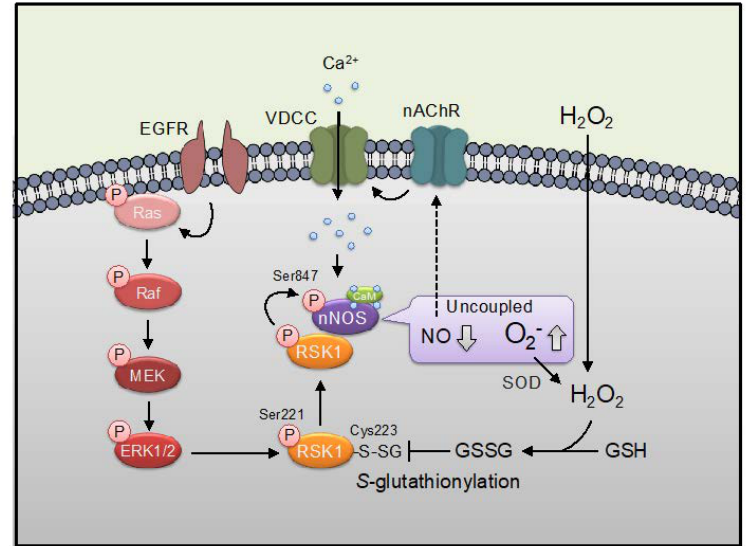
Figure3. HarmonizationofCa 2 + , EGF,andoxidativesignals. Ca 2 + influxinducedbyvoltage-dependent calcium channel (VDCC) via nicotinic acetylcholine receptor (nAChR) activates nNOS, leading NO production. MAPK signaling (Ras / Raf / MEK / ERK) induced by EGF stimuli evokes activation of RSK1 signaling which induces phosphorylation at Ser847 of nNOS. Phosphorylation at Ser847 switches nNOS reaction from NO synthesis to superoxide (O 2 − ) synthesis via induction of uncoupling of nNOS [76] Superoxide is converted to H 2 O 2 by superoxide dismutase (SOD). Oxidative stimulation such as H 2 O 2 and diamide inhibit RSK1 activity via S -glutathionylation at Cys223 of RSK1. nNOS-derived NO can promote the nicotine-induced activation of MAPK (shown by a dashed arrow)